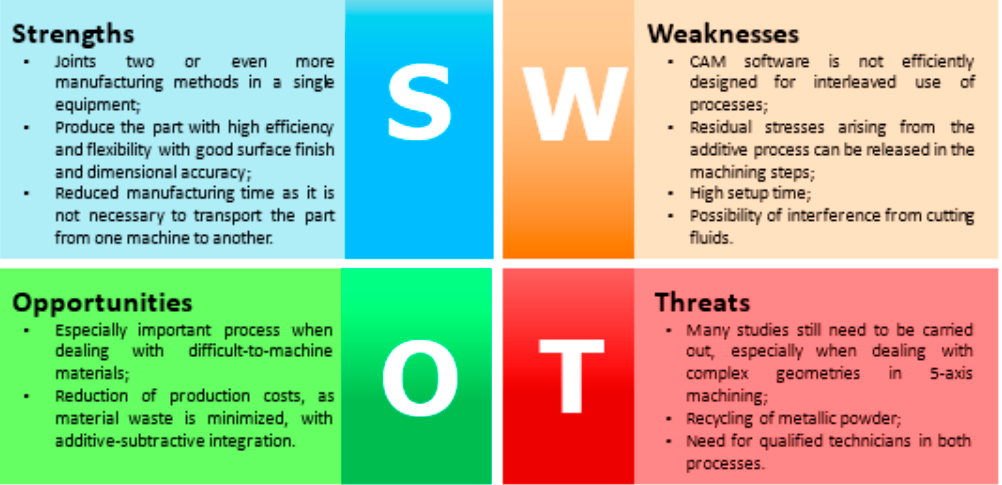
Figure 12. SWOT analysis corresponding to hybrid manufacturing.